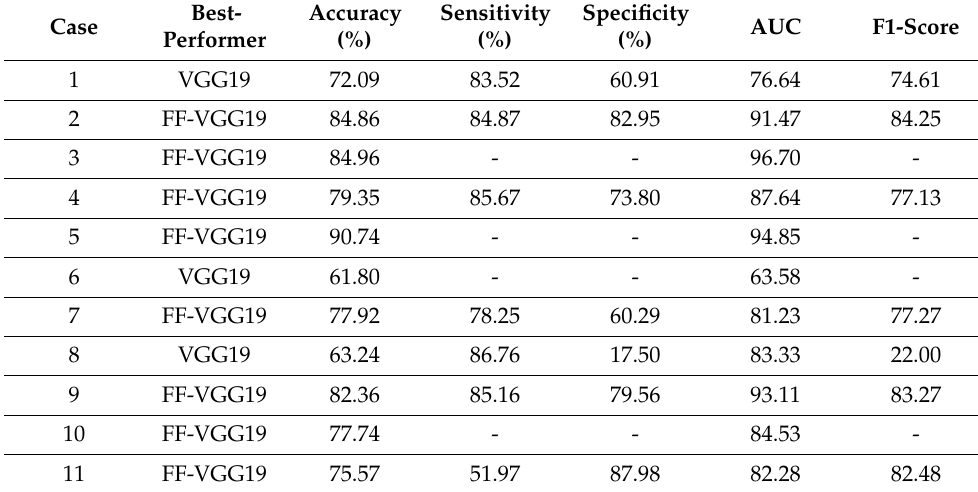
Table 6. Classification metrics of the best CNN for each dataset when training with off-the-shelf features. Some metrics are not computed due to multiclass classification.